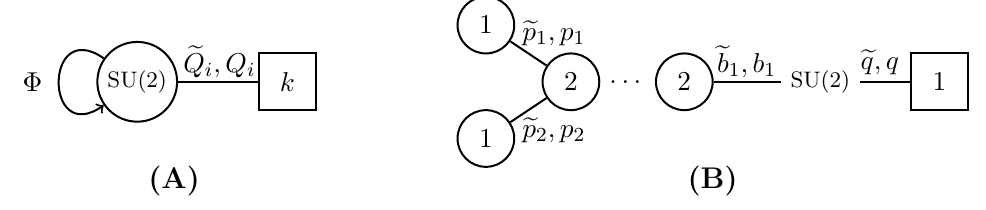
Figure 9. SU(2) adjoint SQCD and its mirror